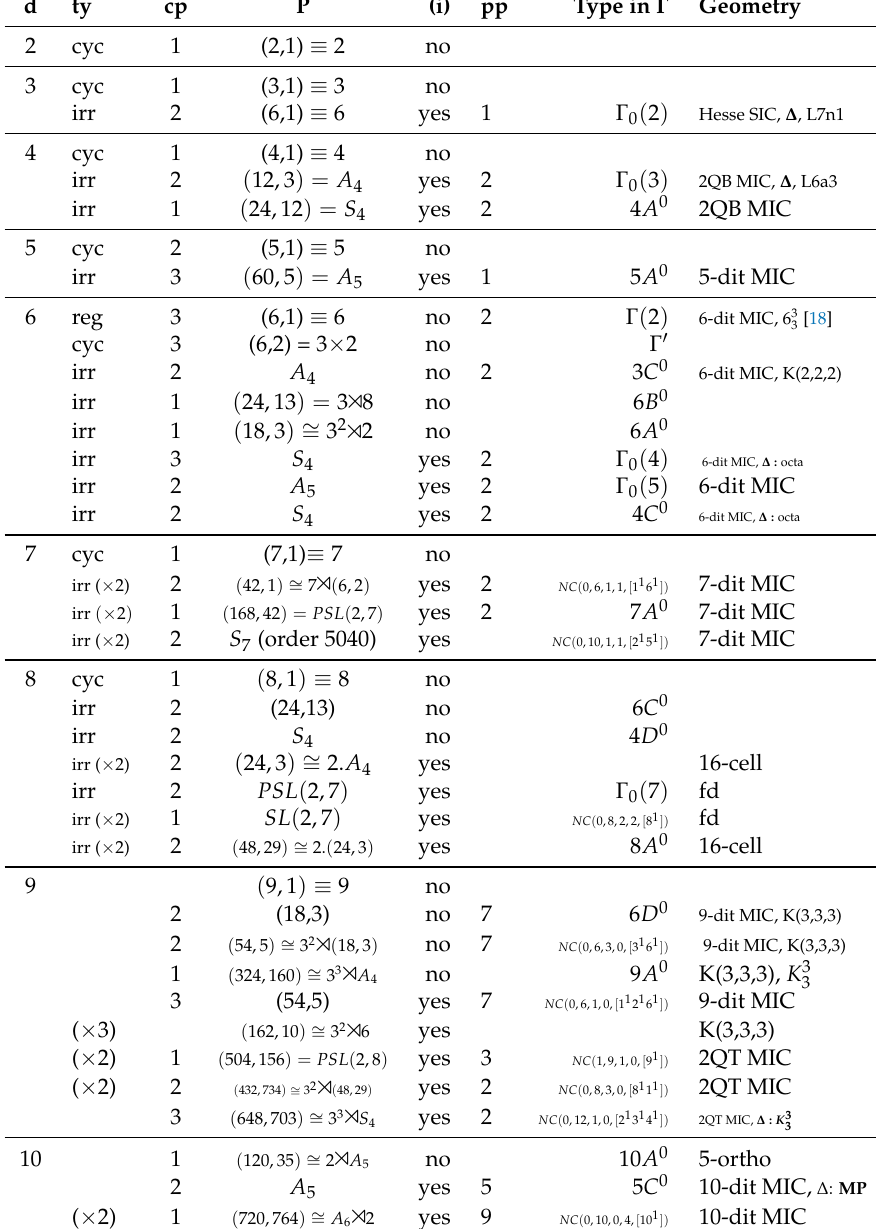
Table 2. Table of 3-manifolds M 3 found from subgroups of finite